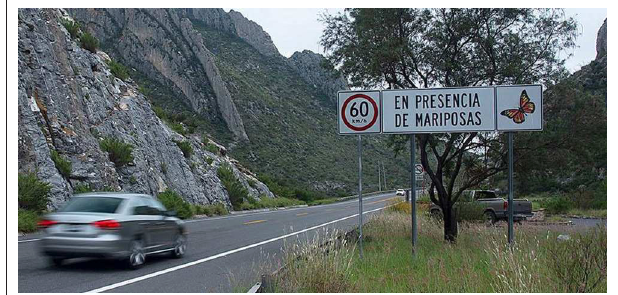
FIGURE 4 | Sign indicating the speed limit 60km/h in the area of monarch highway crossing. Highway 57 at the La Muralla study site, Coahuila. Photo by Omar Franco